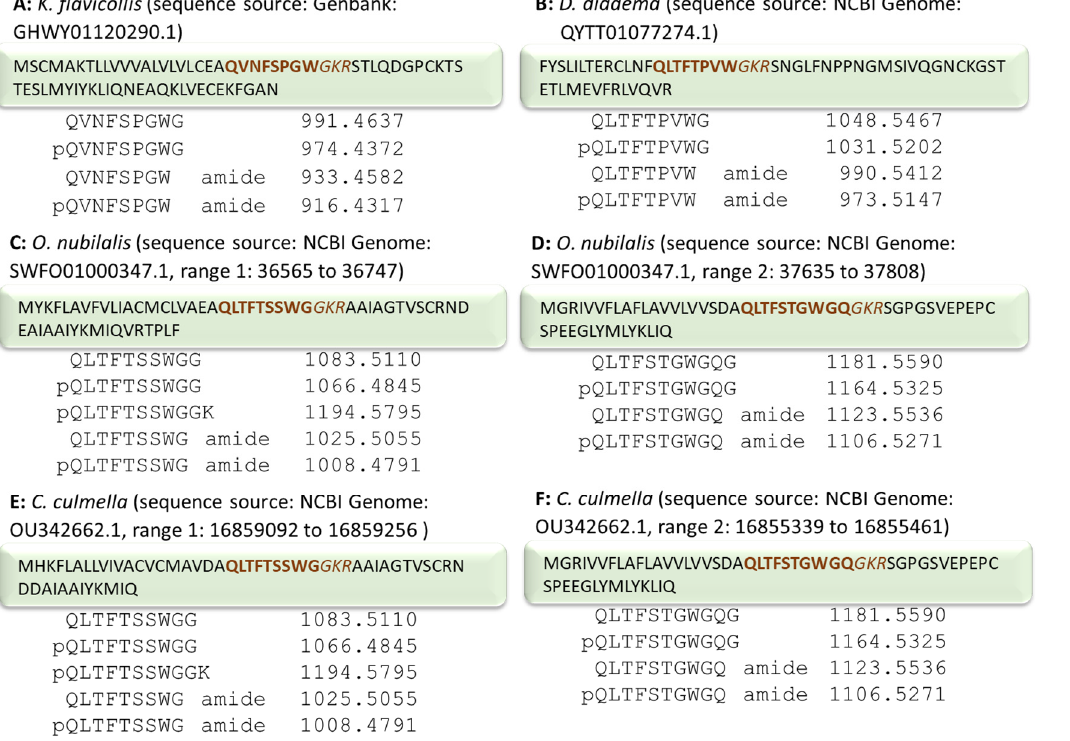
Figure 1. Amino acid sequences for putative mature AKHs deduced from precursor sequences mined from various databases. The sequence of the encoded potential AKH is given in bold letters and the possible amidation site plus dibasic cleavage site in italics . The calculated protonated mass for potentially processed peptide is shown. The insects are Kalotermes flavicollis ( A ), Dasypogon diadema ( B ), Ostrinia nubilalis ( C , D ), and Chrysoteuchia culmella ( E , F ).